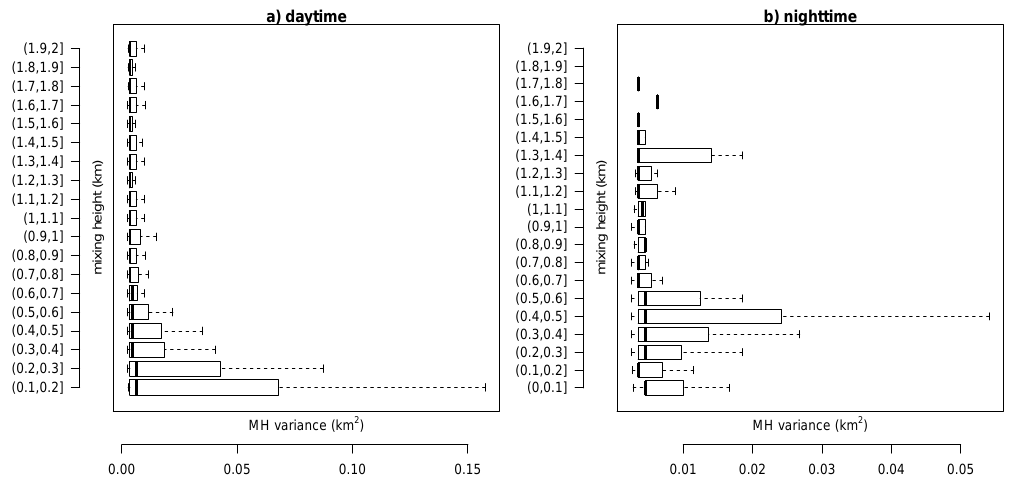
Figure 2. Uncertainty of the calculated MH with height (a.g.l.) shown in 100m bins for daytime (a) and night-time (b) . The uncertainties were estimated using Eq. ( 2). All available IGRA observations were used for the calculations. Daytime values are shown starting from 100m (a.g.l.). Boxes denote the central 50% of the data, whiskers are at ± 1.5 times the inter-quantile range and outliers are not shown. Black line within boxes indicate the median